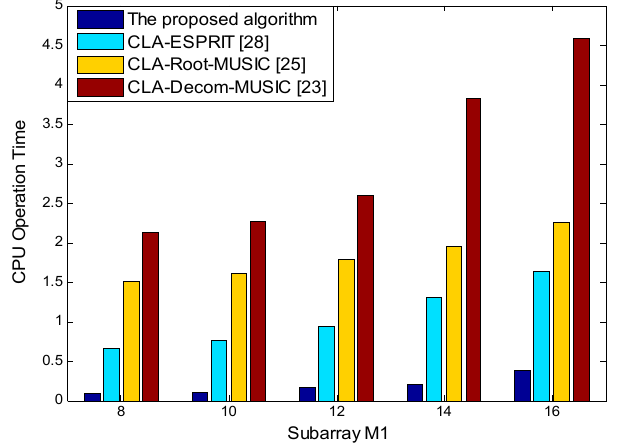
Figure 6. Computational complexity analysis.